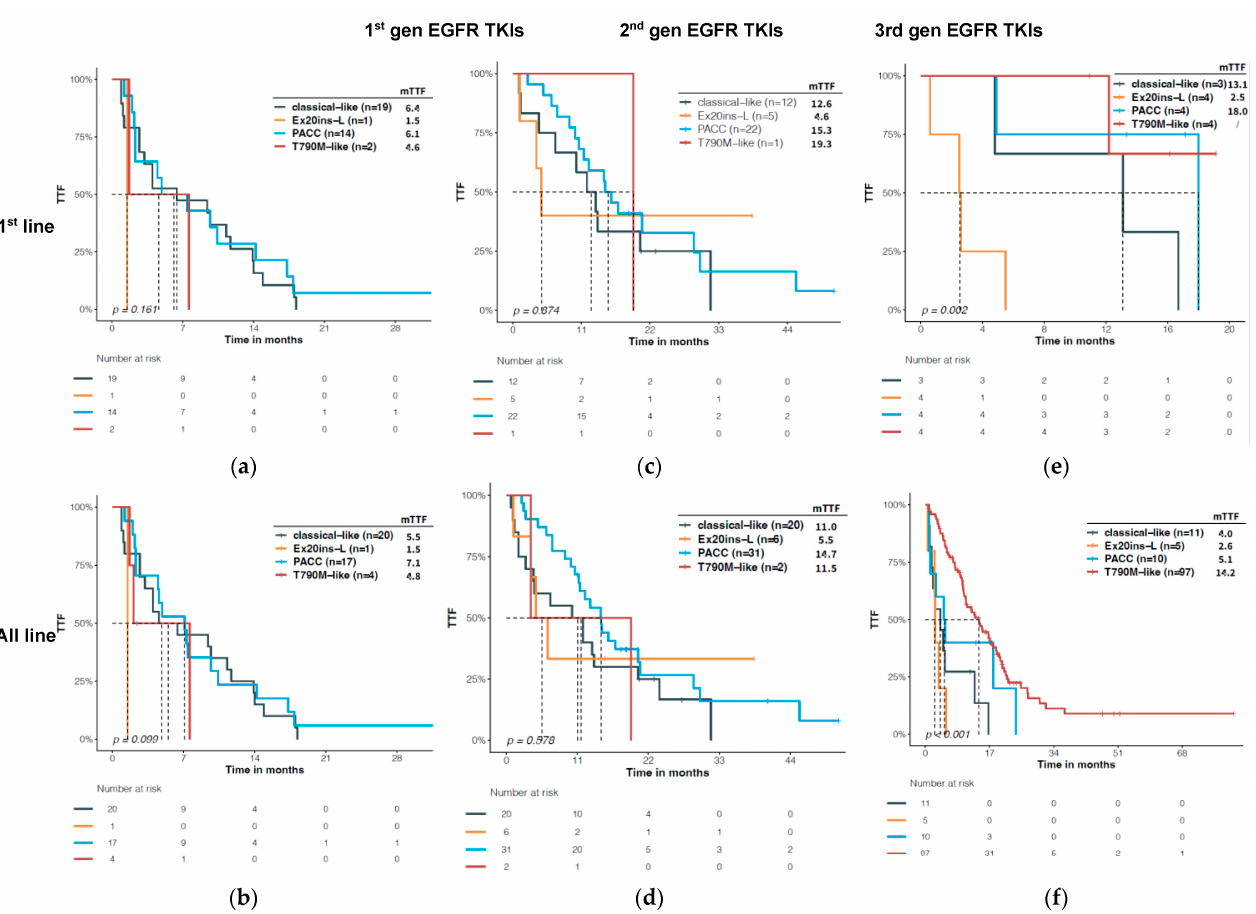
Figure 4. Predictive significance of the structural classification on EGFR mutations for different EGFR TKIs. Time to treatment failure (TTF) was compared among different structural groups upon 1st, 2nd, and 3rd gen EGFR TKI as 1st line treatment ( a – c ) or regardless of treatment line ( d – f ). 19del and L858R were excluded from the classical-like subset for this analysis.